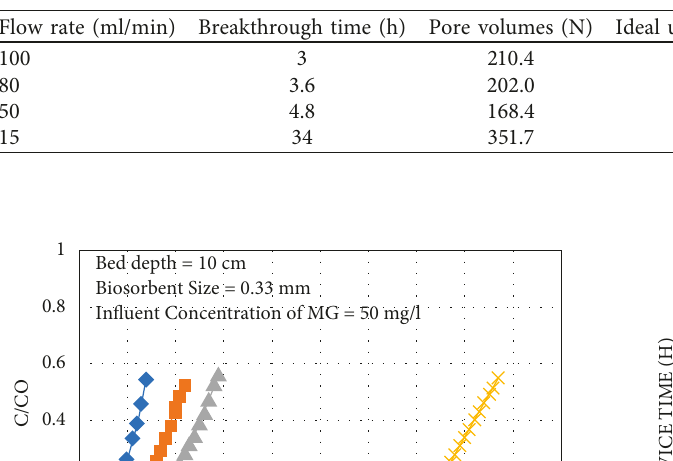
Table 3: Effect of flow rate.